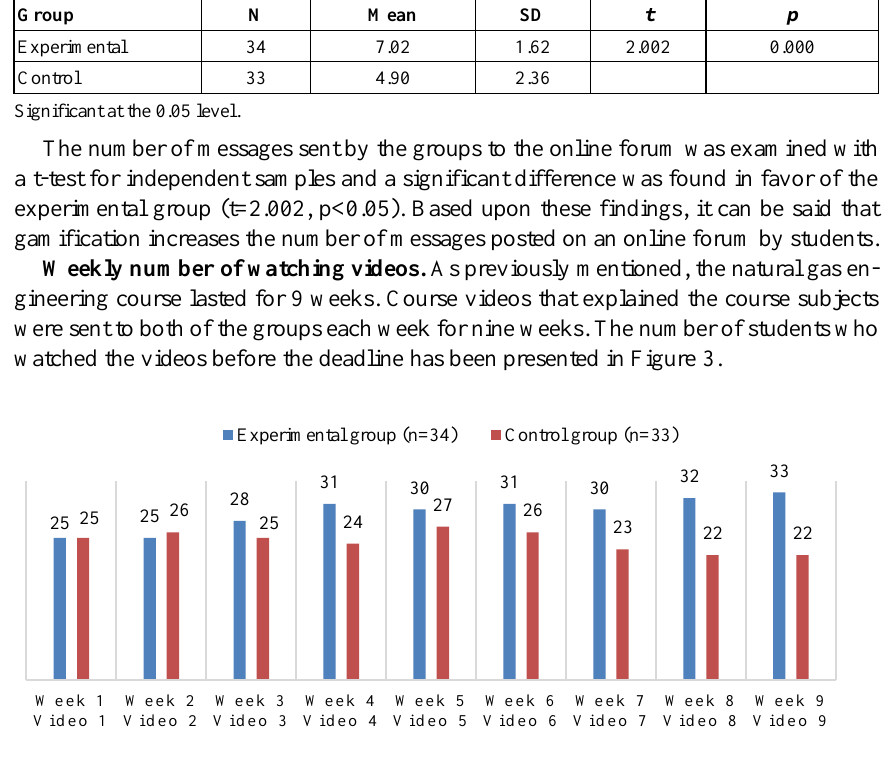
Fig. 3. The number of students who watched the videos before the weekly